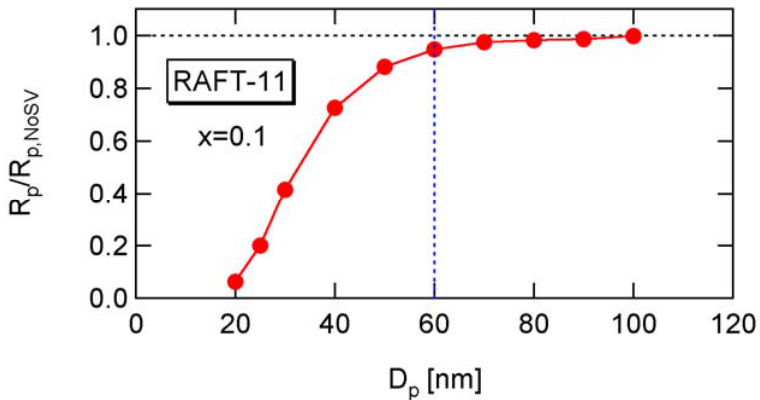
Figure 18. Ratio between the true miniemulsion rate R obtained by using the average concentrations without accounting for the statistical for RAFT-11 at x = variation effect R p,NoSV